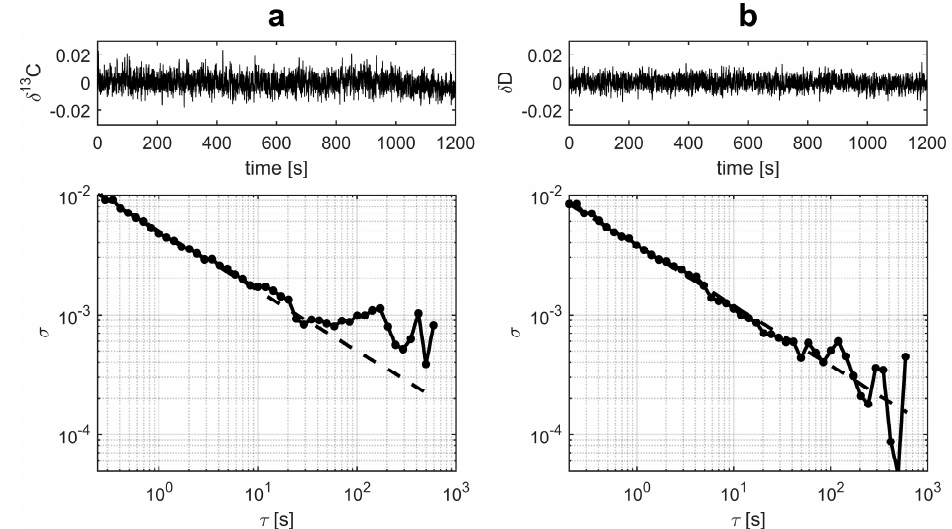
Figure 4. Typical Allan deviation plot for δ 13 C ( a ) and δ D ( b ) in CH 4 . The filled circles show the experimental data and the dashed line shows the theoretical 1/f random noise behavior.